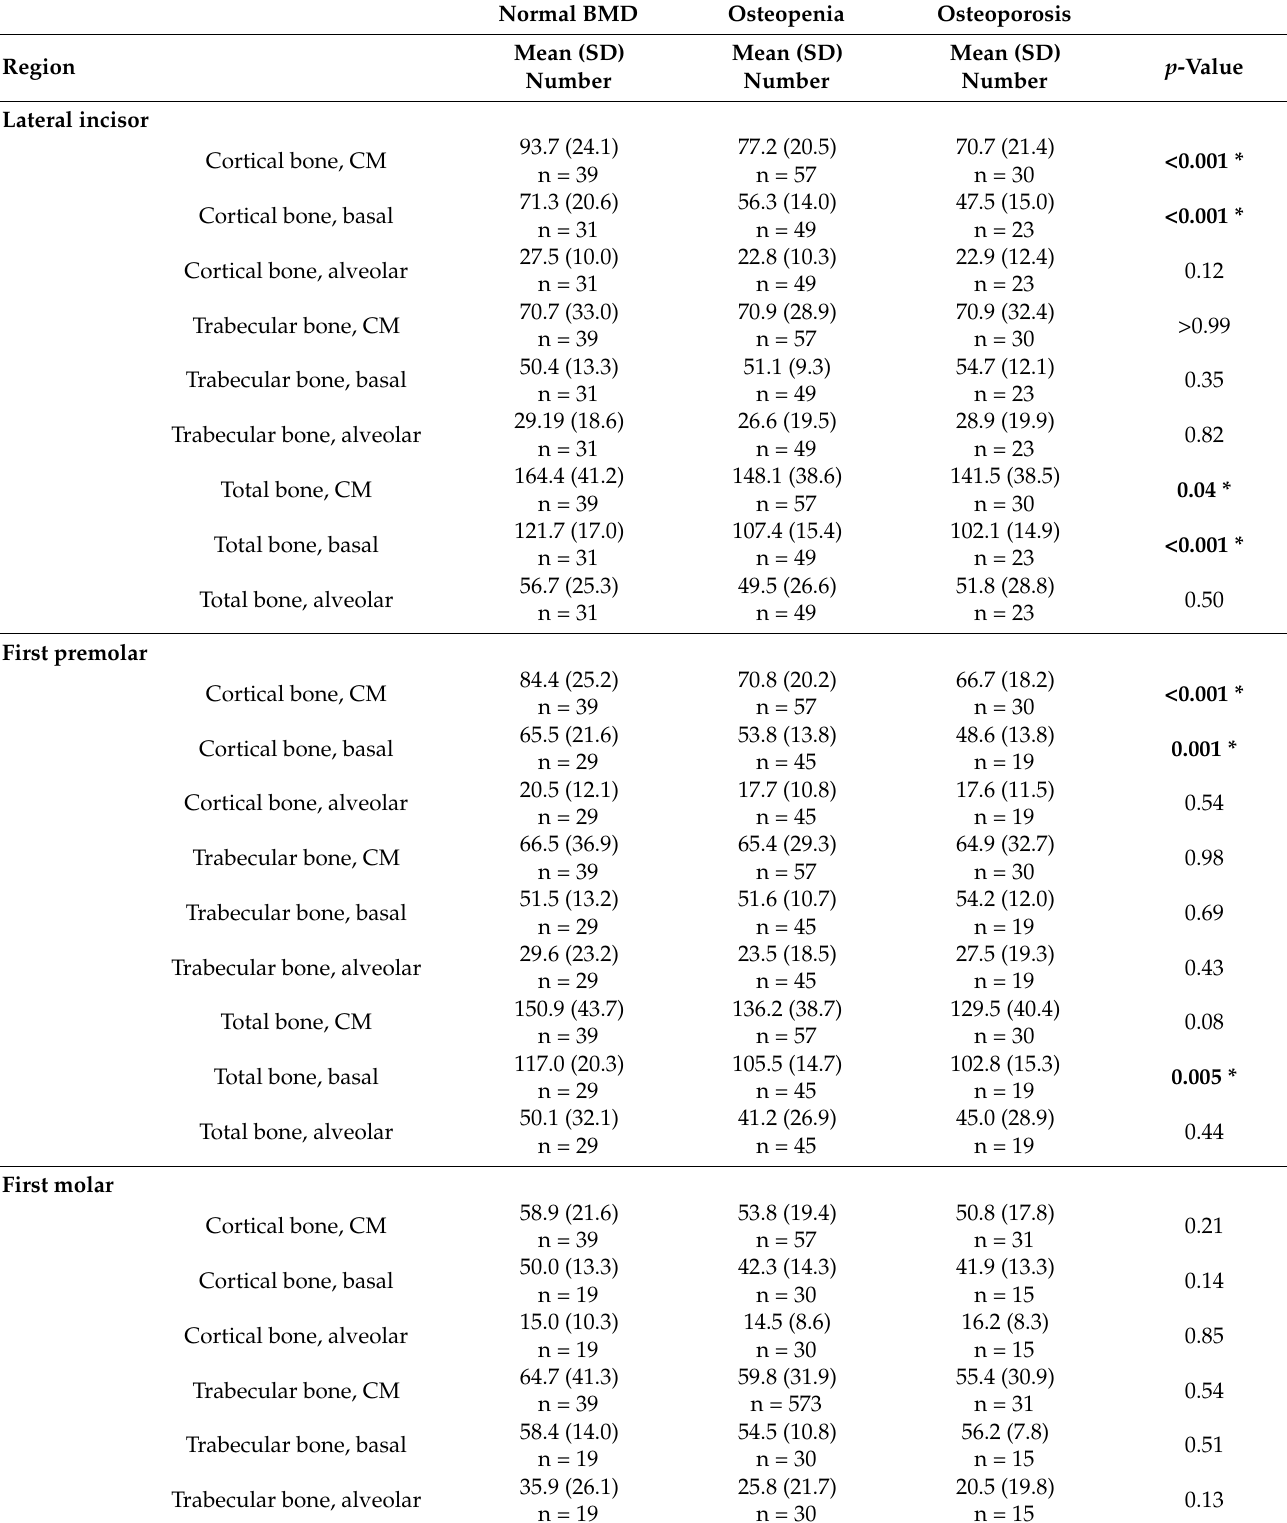
Table 2. Means, standard deviations, and one-way ANOVA results for total bone volume, trabec- ular bone volume, and cortical bone volume in the complete, alveolar part, and basal part of the mandibular body in the normal BMD, osteopenia, and osteoporosis